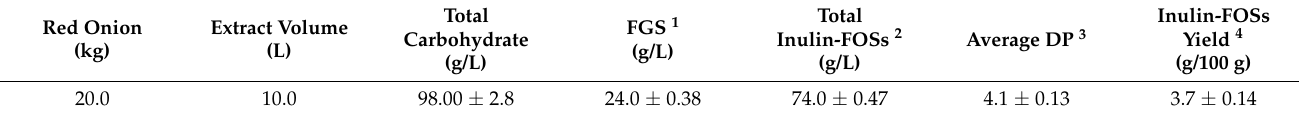
Table 1. Summary of inulin-FOSs extract obtained from red